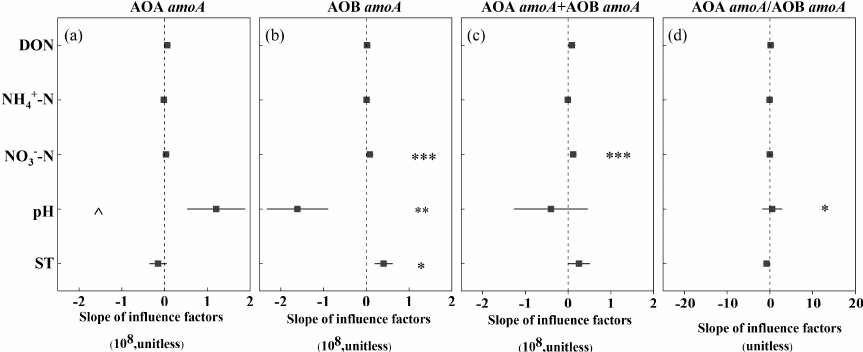
Figure 4. Slope of influencing factors of the ( a ) AOA amoA gene; ( b ) AOB amoA gene; ( c ) AOA amoA gene + AOB amoA gene; and ( d ) AOA amoA /AOB amoA . Note: ^ Significant at the 0.1 probability level; * Significant at the 0.05 probability level; ** Significant at the 0.01 probability level; *** Significant at the 0.001 probability level.